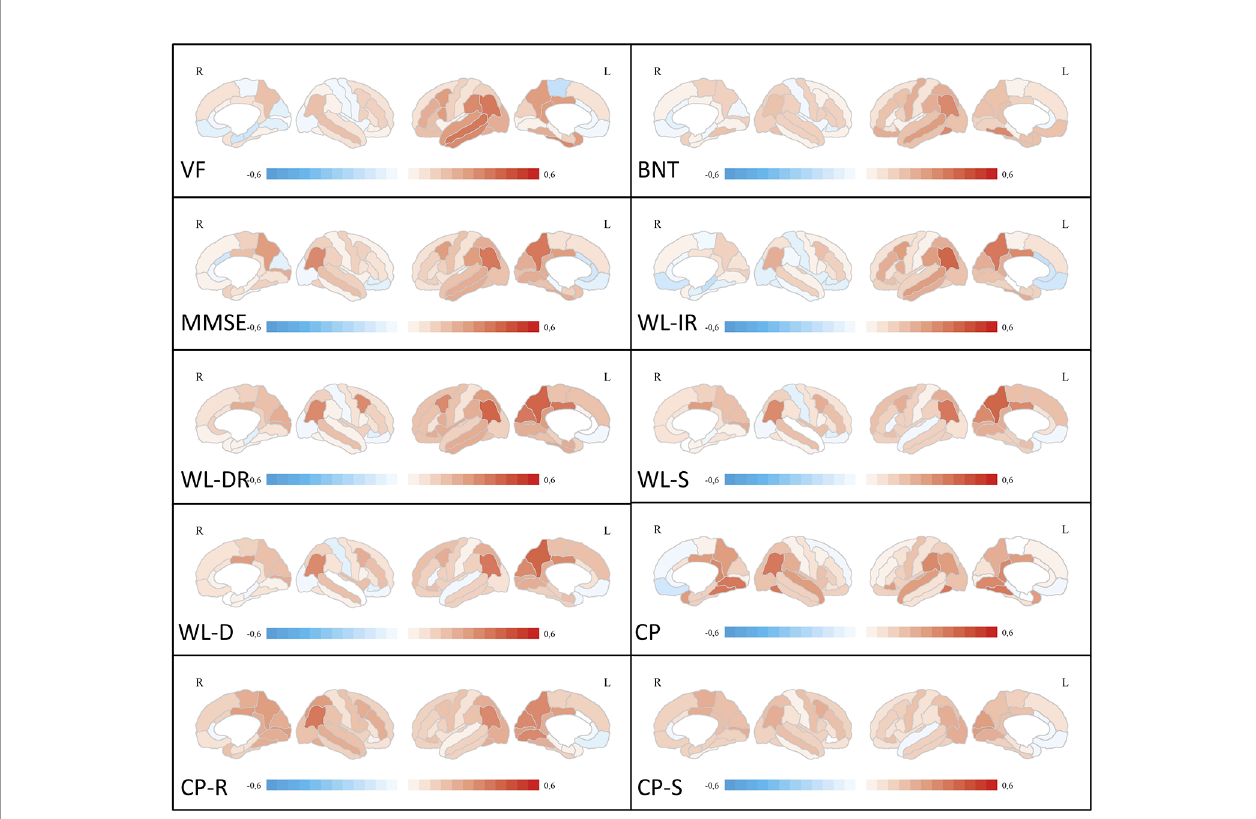
FIGURE 3 | Correlation analyses between ROI-based cortical thickness and neuropsychological test scores. Medial and lateral projections of the right and left hemisphere are shown. Red color depicts positive correlations (Pearson ’ s r), blue color depicts negative correlations. Maximum Pearson ’ s r is set at -0.6 and 0.6, respectively. Verbal fl uency (VF), Boston Naming Test (BNT), Mini-Mental State examination (MMSE), Word List Immediate Recall (WL-IR), Word List Delayed Recall (WL-DR), Word List Savings (WL-S), Word List Discriminability (WL-D), Constructional Practice (CP), Figures Recall (CP-R), Figures Savings (CP-S). ROI, region of